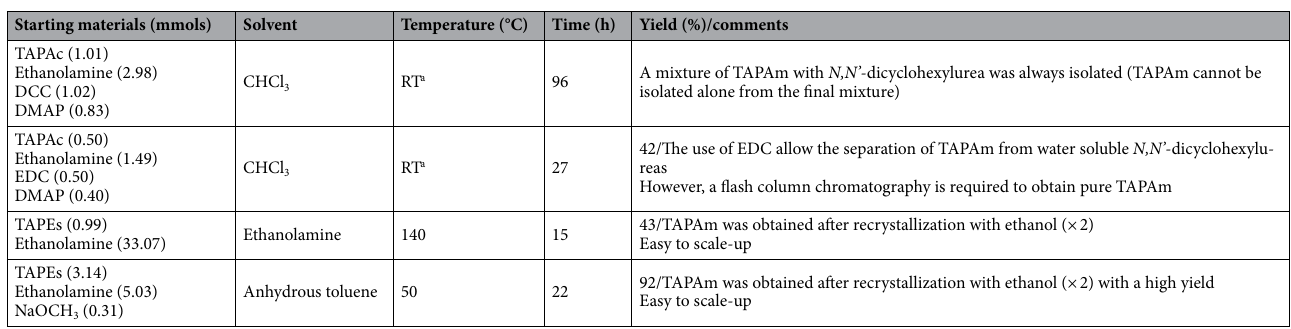
Table 1. Starting materials, solvent, reaction conditions and results of the distinct chemical reactions carried out to obtain TAPAm. a RT, room temperature = 20 ± 3